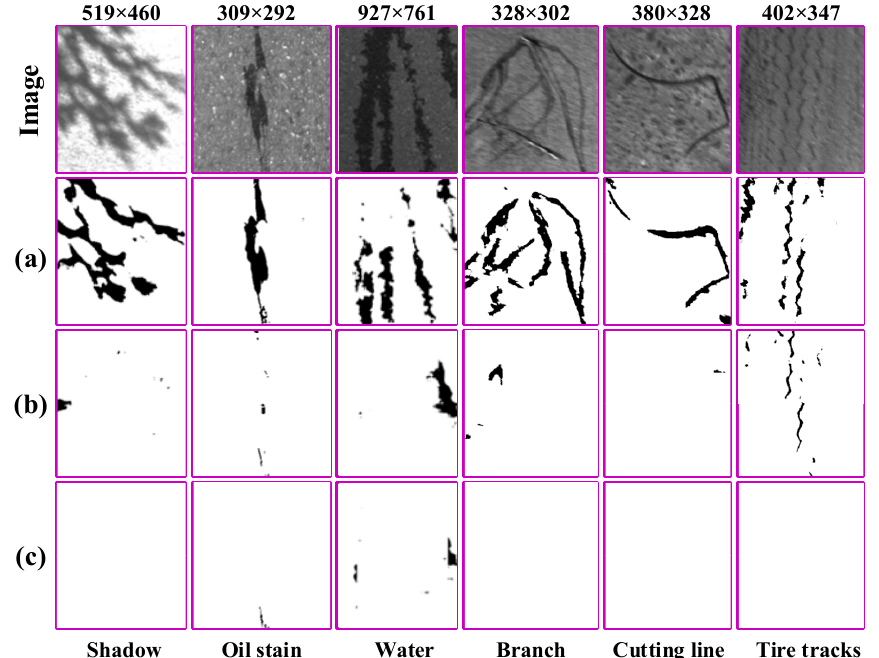
Figure 12. The influence of negative samples on fracture extraction. ( a ) SegFormer prediction results when negative samples are not used in the training. ( b ) SegFormer prediction results when 5000 negative samples are used in the training. ( c ) SegFormer prediction results when 11,781 negative samples are used in the training.